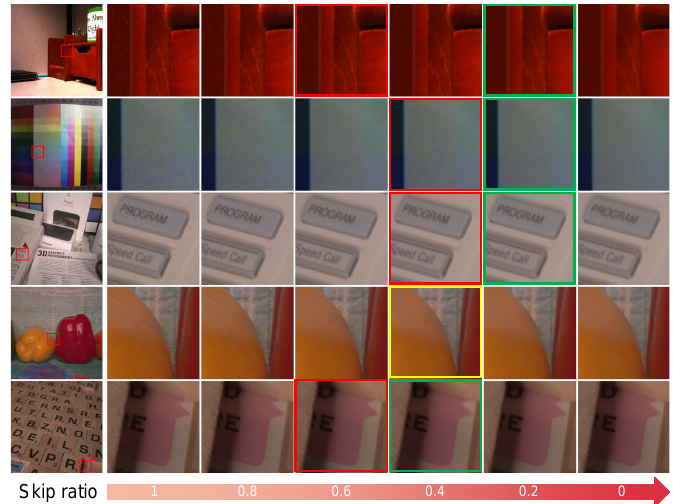
Figure 5. Denoising results vary as the skip ratio increases.